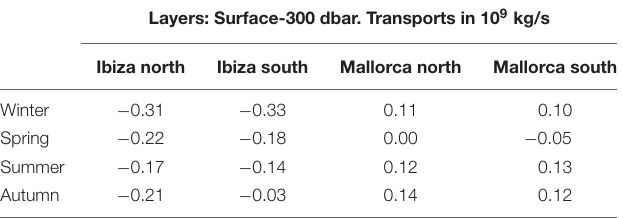
TABLE 3 | Transports in 10 9 kg/s for the four sections analyzed in this work. Layers: Surface-300 dbar. Transports in 10 9 kg/s